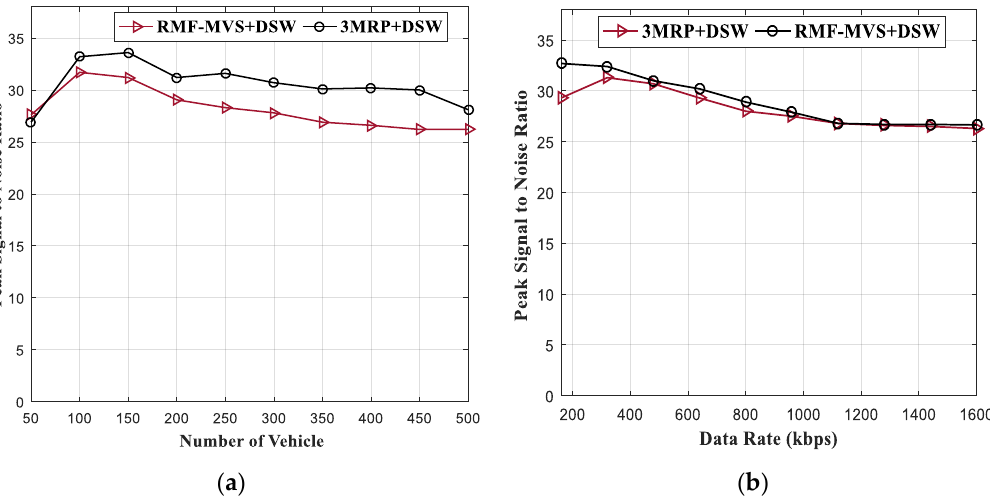
Figure 9. Based on Varied Number of ( a ) Vehicles and ( b ) Data Rates Considering Dynamic Weighting Score.